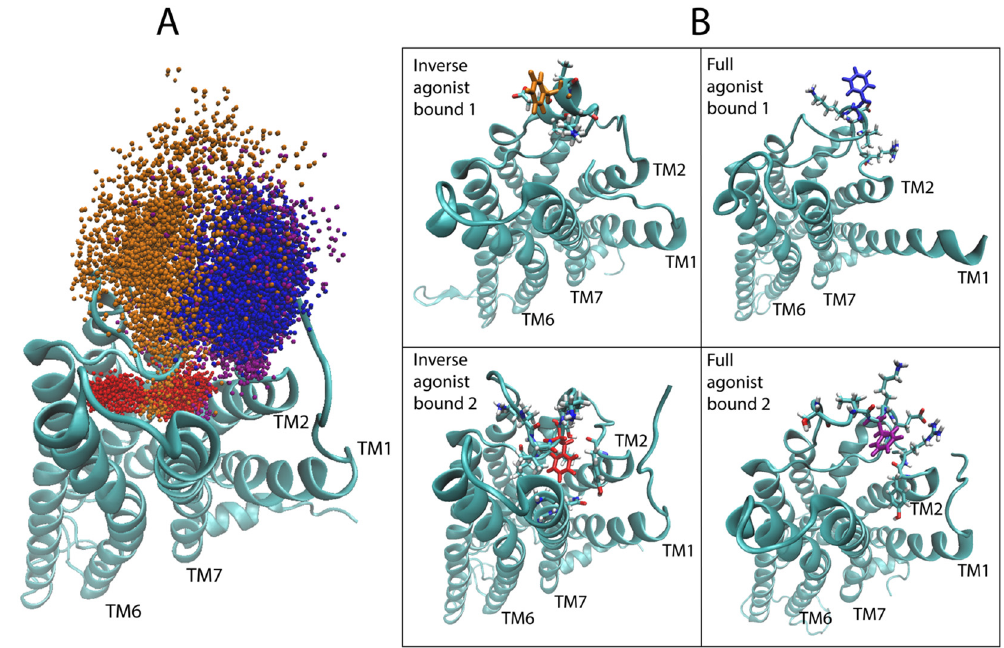
Figure 8. Conformational dynamics of residue F222 in ECL2 identified by the positions of the epsilon carbon atom C ε of F222 in the simulation trajectories. ( A ) Sampling of the coordinates of C ε of F222 (atom 2532), the top hit of the sensitivity analysis for serotonin (5-HT), in the aligned trajectories of the 5-HT 2A R bound to the inverse agonist ketanserin (KET) (red and orange) and the full agonist 5-HT (blue and purple). ( B ) Representative frames from each of the four trajectories shown in the previous panel. F222 is colored solidly according to the bound ligand, ketanserin (red and orange) and serotonin (blue and purple).